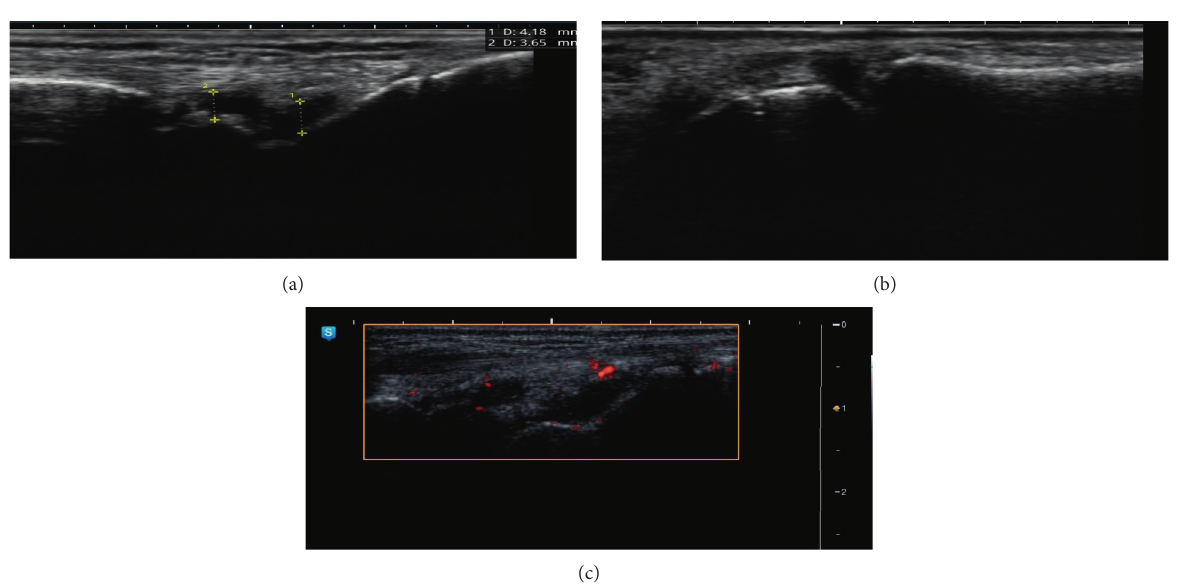
Figure 1: (a) Ultrasonographic examination of the wrist of an RA patient showing synovial thickness: at radiocarpal � 4.18mm and intercarpal � 3.65mm, (b) ultrasonographic examination of the wrist of an RA patient showing grade 2 carpal bone erosion, and (c) ultrasonographic examination of the wrist of an RA patient showing grade 2 Doppler